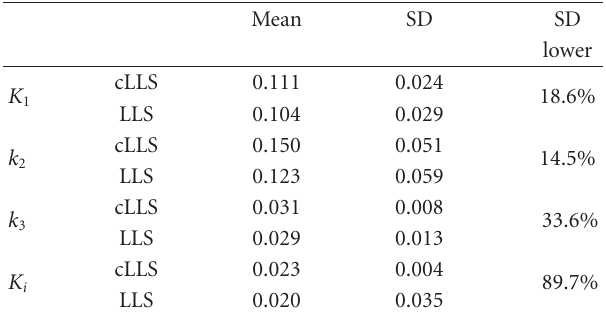
Table 3: Pixelwise comparison on mean and SD of parametric im- ages (paired t-test, P <